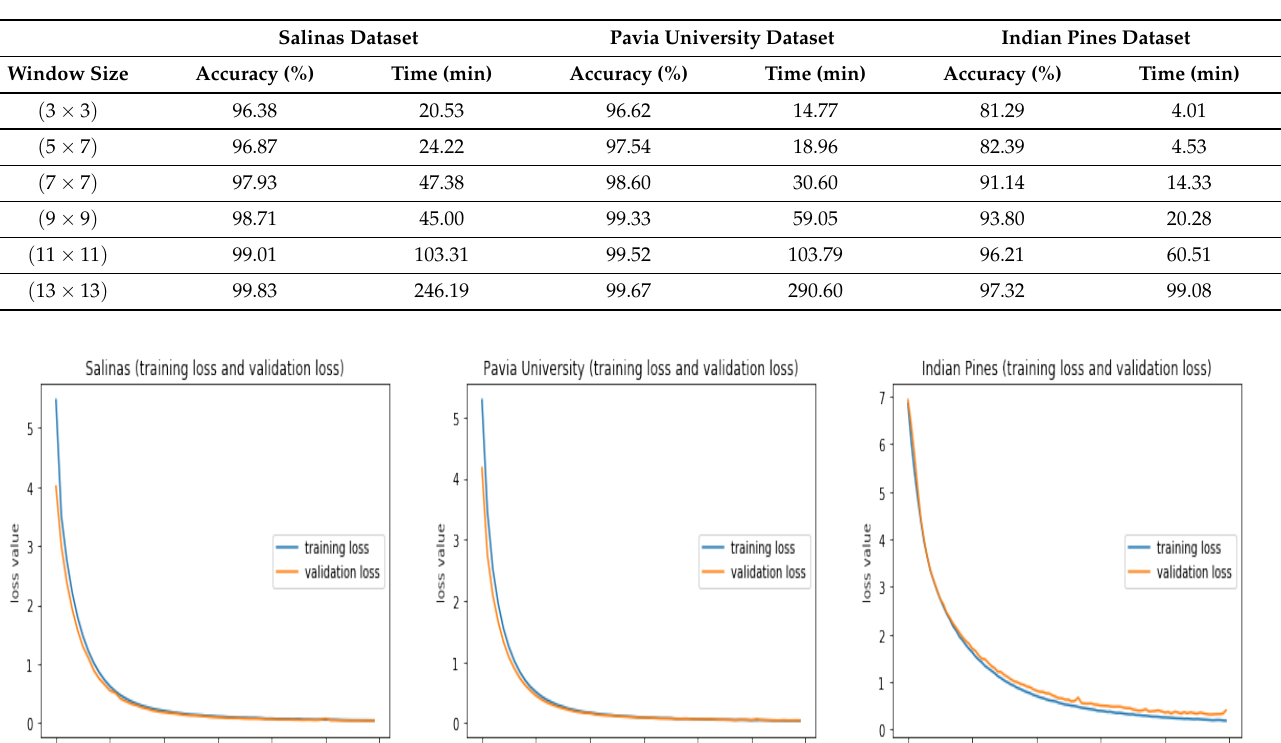
Table 8. Classification results of the proposed SPAT-SPEC-HYP-ATTN methodology on varying spatial window sizes for 5% training data.